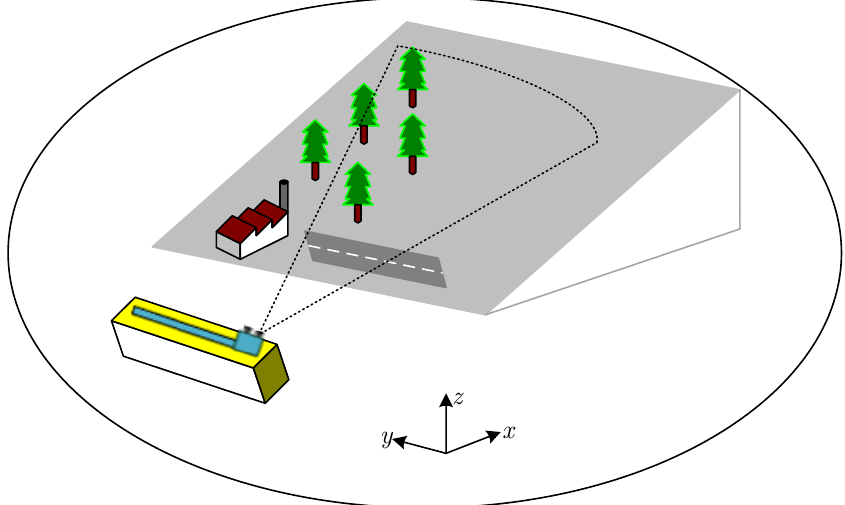
Figure 1. Observation geometry of fround-based synthetic aperture radar (GB-SAR).